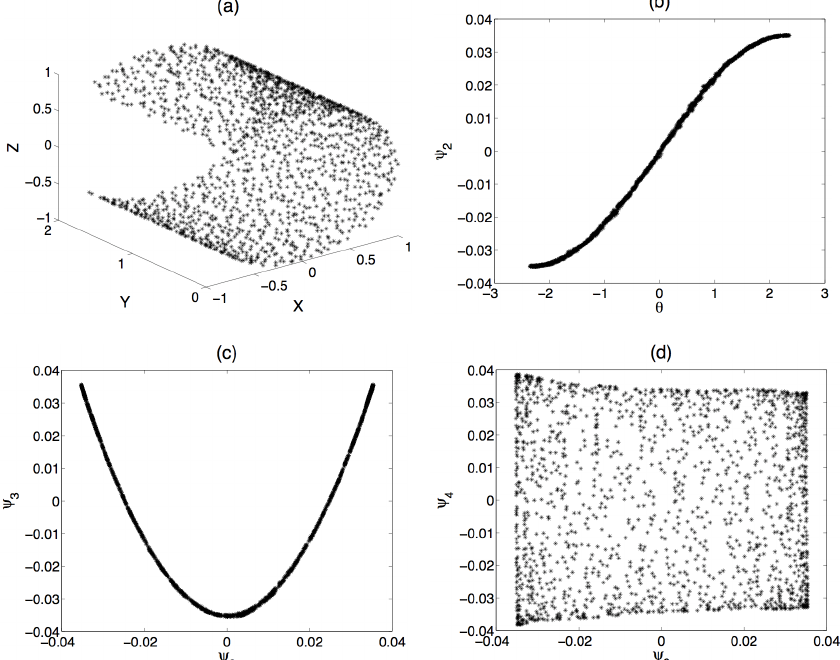
Figure 2. More on the effect of data sampling: noise. ( a ) One thousand six hundred points are initially randomly placed in each of the 40 by 40 array of small squares, forming the unit square, and, afterwards, bent around a cylinder; ( b ) entry in the first non-trivial eigenvector of the Markov matrix, K , vs . the first cylindrical coordinate, θ , for each data point; ( c ) entry in the second non-trivial eigenvector of K vs . the first one; ( d ) entry in the third non-trivial eigenvector of K vs . the first